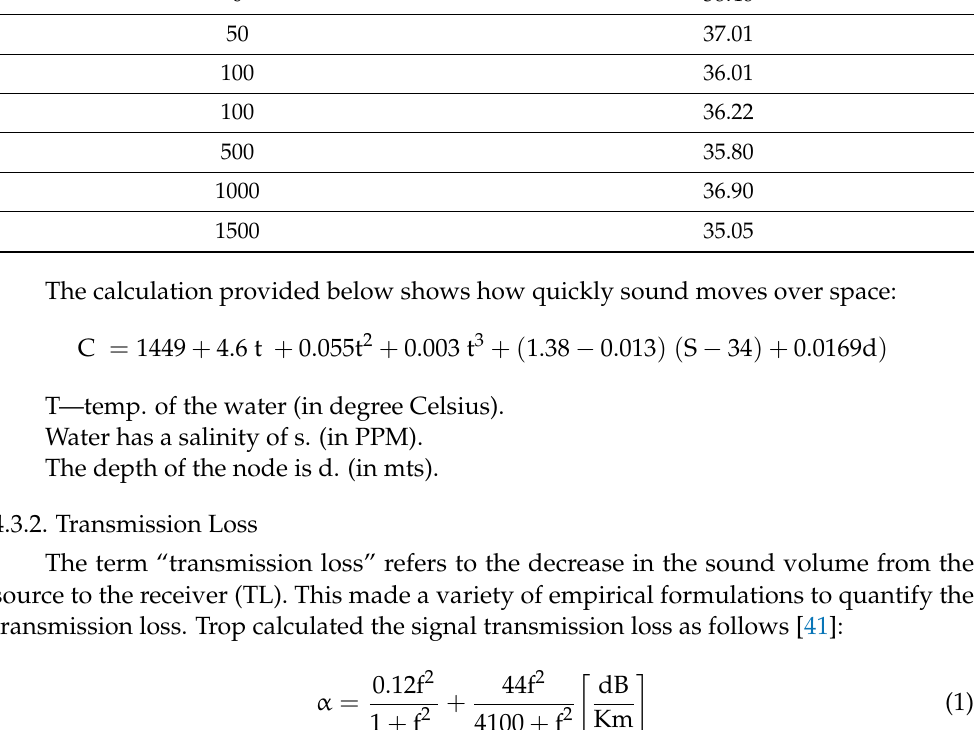
Table 3. Salinity contingent on the water depth. Depth (m) Salinity (PPM)